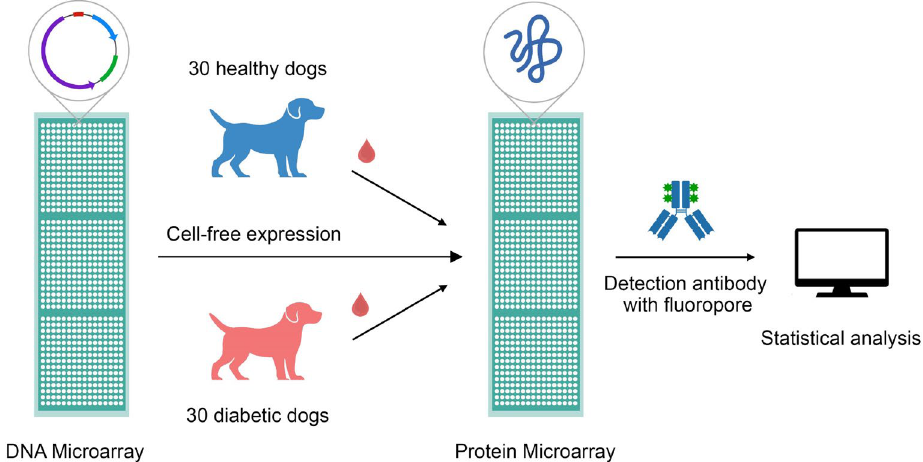
Figure 1. Flowchart explaining the study design. Initially, a DNA microarray is printed which is expressed using cell-free expression kit to make it a protein microarray. Sera from dogs were added followed by addition of detection antibodies.